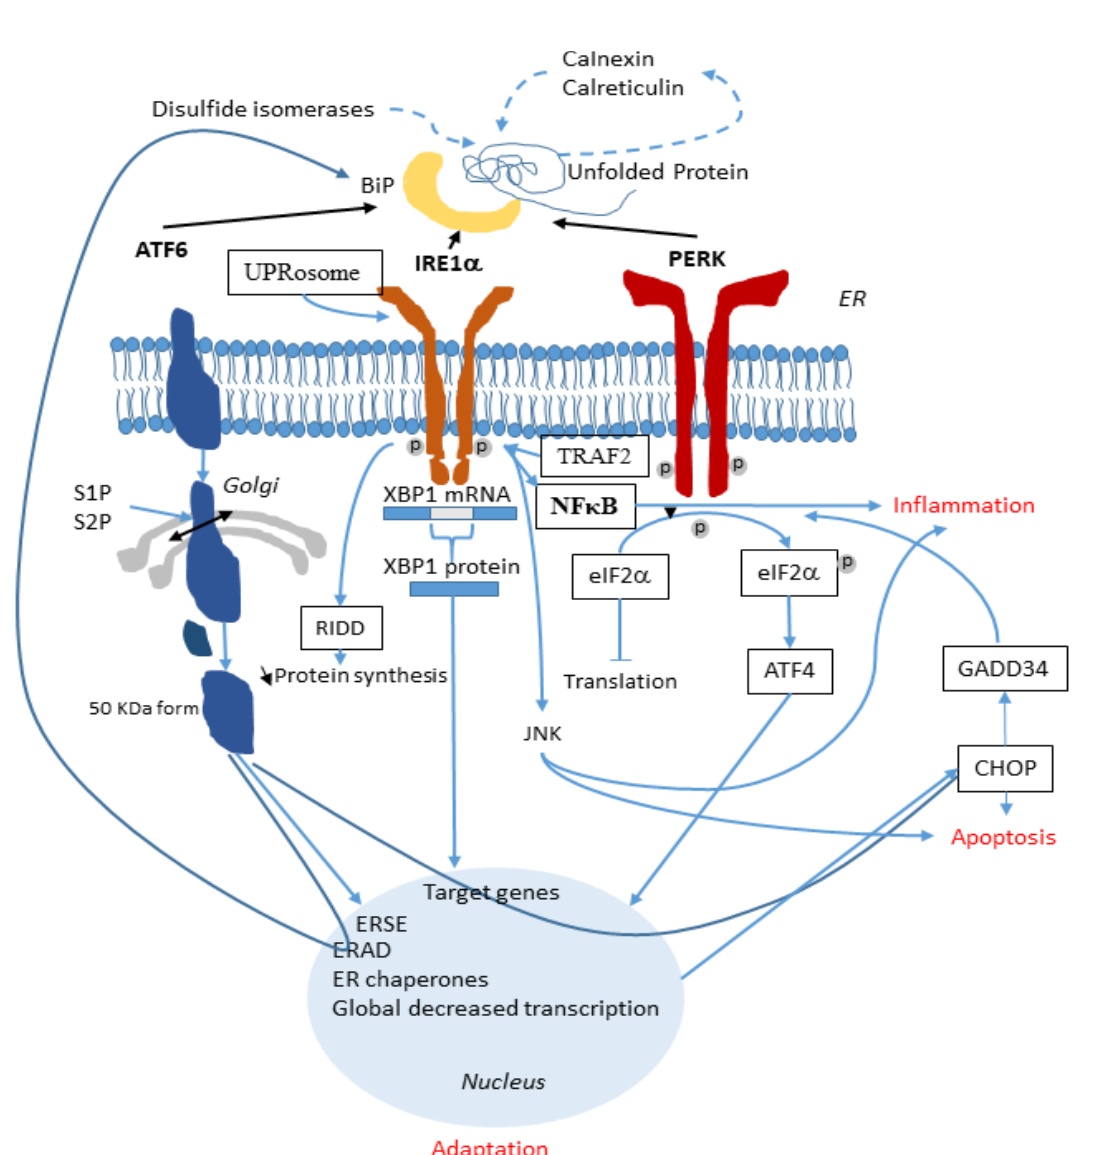
Figure 2. Involvement of the UPR in the inflammatory response. In the ER, when ATF6, IRE1 α and PERK are released from BiP, they activate the UPR (black lines). ATF6 is cleaved by S1P and S2P and its active form migrates to the nucleus. IRE1 α splices XBP1 mRNA and the XBP1 protein is translocated to the nucleus. PERK phosphorylates eIF2 α which also reach the nucleus. These three arms of the UPR activate specific genes aimed at alleviating the ER stress. During this process, inflammation is triggered (blue lines). A synergistic effect of both IRE1 α and PERK permits the complete NF- κ B activation through an interaction between IRE1 α and TRAF2 and through the JNK pathway. UPR also activates the release of the pro-inflammatory IL-6 and IL-8. NF- κ B is the main link between UPR and